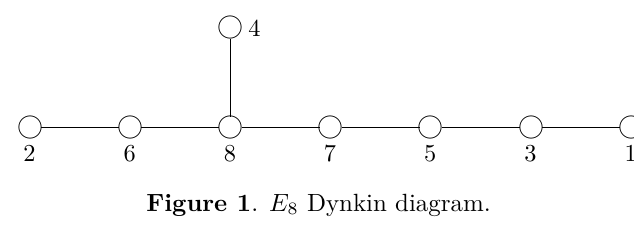
Figure 1 . E 8 Dynkin